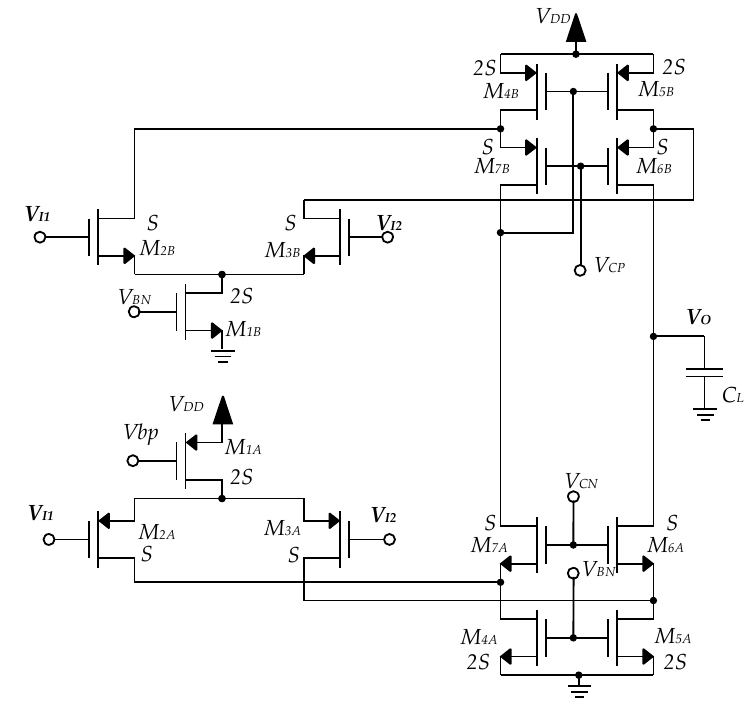
Figure 4. Topology of the implemented folded cascode amplifier used as reference.